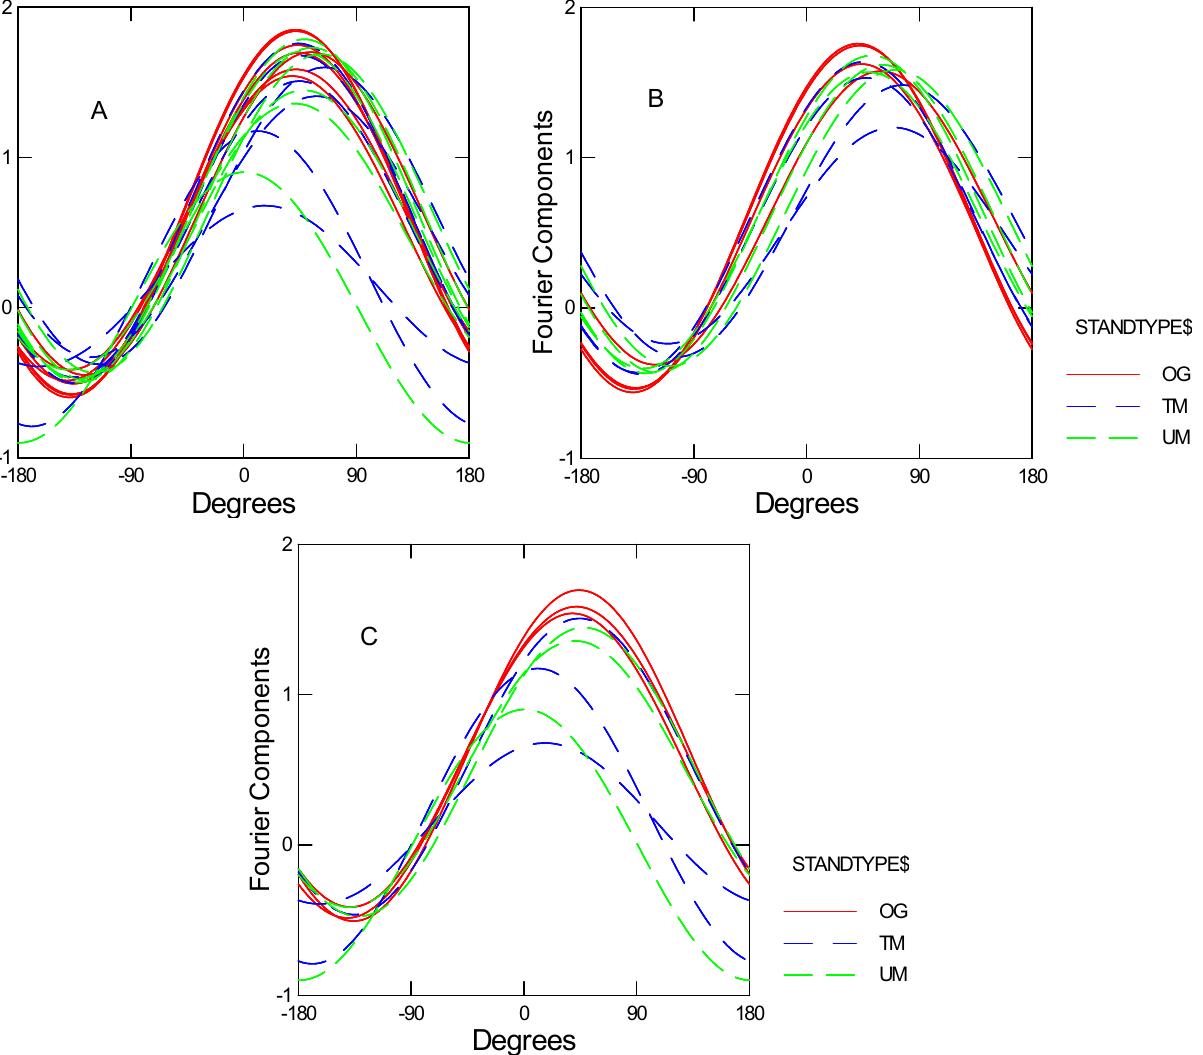
Figure 9. Andrews Fourier Plots of multivariate model 1 (Table 5: Log (AMN), Log (Soil mesofauna richness, Log (soil mesofauna abundance)). Each curve represents one stand. AMN = anaerobic mineralizable nitrogen. ( A ) All regions; ( B ) Cascades and Coast Ranges; ( C )